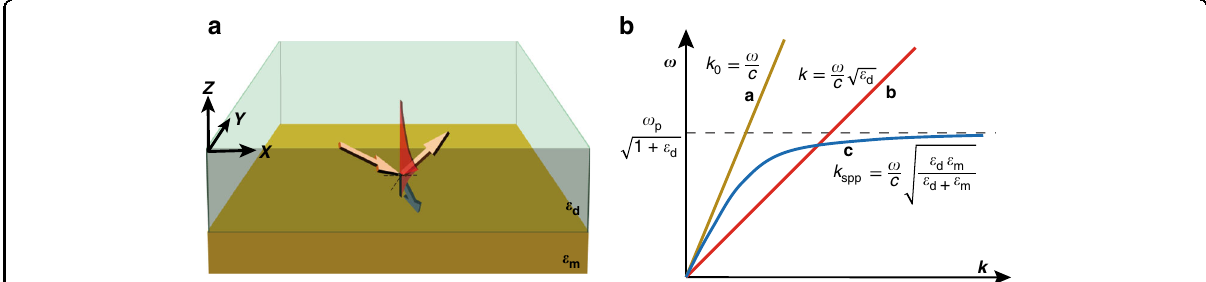
Fig. 1 SPP excitation and its dispersion proterties. a Surface plasmon polariton excitation at a dielectric – metal interface. b Dispersion relationship curves of light in free space, light in a dielectric and surface plasmon plaritons. Here, ω P is the frequency of bulk longitudinal electron excitations, i.e., the plasma frequency